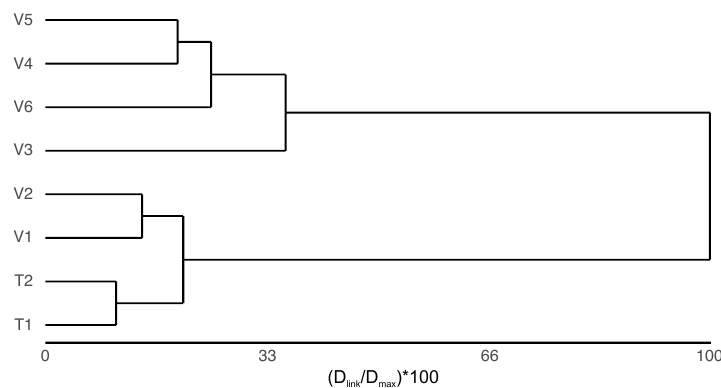
Figure A2. Dendogram of the sample sites based on the physical, chemical and microbiological data in the Virilla river.